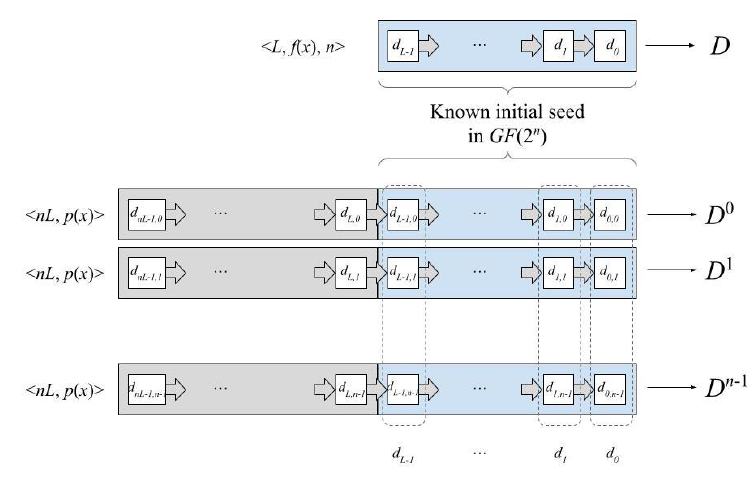
Figure 3. LFSR seeds in the binary equivalent